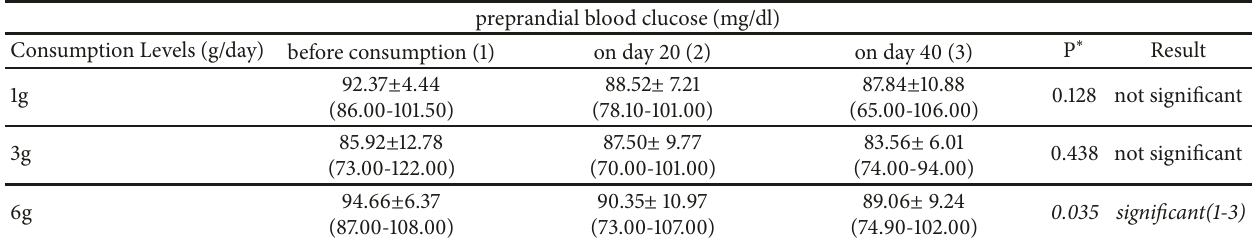
Table 3: Effect of cinnamon on preprandial blood glucose level.